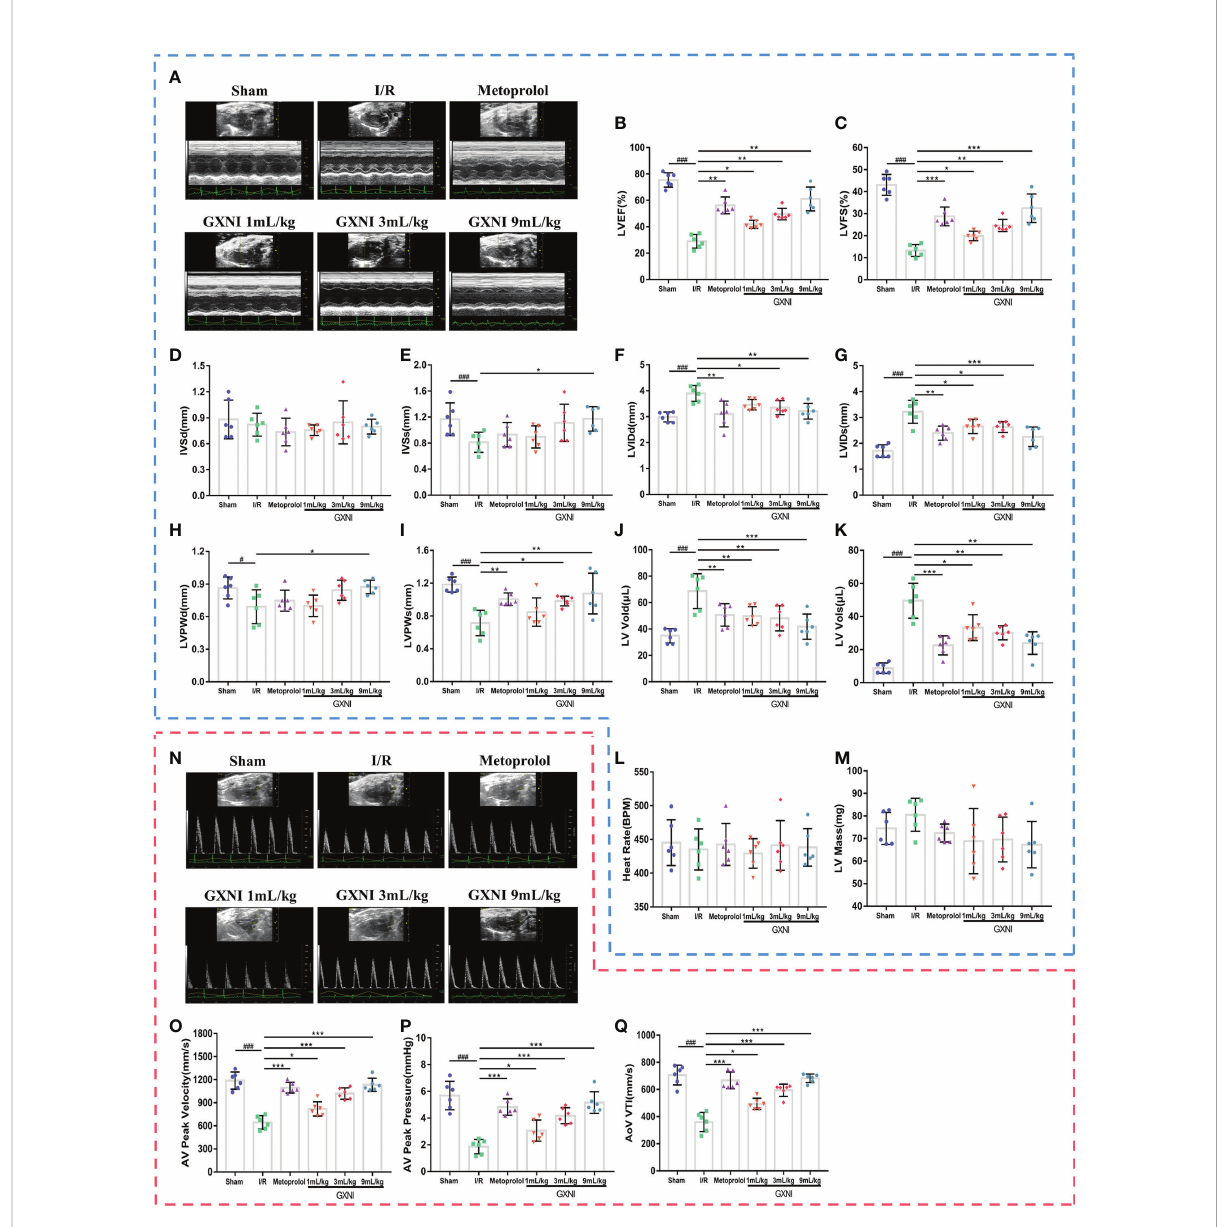
FIGURE 1 The effect of GXNI on echocardiographic characteristics of cardiac function and coronary blood fl ow in I/R mice. After 30 min of ischemia and 24 hrs of reperfusion, the cardiac function and coronary blood fl ow of mice in each group were evaluated. (A) Representative echocardiographic images of sham group, I/R group, metoprolol group and different GXNI dose (1 mL/kg, 3 mL/kg, 9 mL/kg) groups. Quanti fi cation of echocardiographic changes in cardiac function in different groups detected in M mode: (B) LVEF %, (C) LVFS %, (D) LVSd, (E) LVSs, (F) LVIDd, (G) LVIDs, (H) LVPWd, (I) LVPWs, (J) LV Vold, (K) LV Vols, (L) heart rate and (M) LV mass. (N) Representative echocardiography images of coronary blood fl ow images of each group. (O) AV peak velocity, (P) AV peak pressure and (Q) AoV VTI were determined in color Doppler mode. Values were expressed as mean ± SEM (n = 6). ### P < 0.001, # P < 0.05 vs. sham group, * P < 0.05, ** P < 0.01, *** P < 0.001 vs. I/R group (LV, left ventricular; EF, ejection fraction; FS, fractional shortening; LVSd, LV end diastolic septal thickness; LVSs, LV septal thickness at end systole; LVIDd, LV internal dimensions at diastole; LVIDs, LV internal diameter systole; LVPWd, LV posterior wall diastole; LVPWs, LV posterior wall systole; LV Vold, LV diastole volume; LV Vols, LV systole volume; AV, aortic valve; AoV VTI, aorta velocity – time integral mean